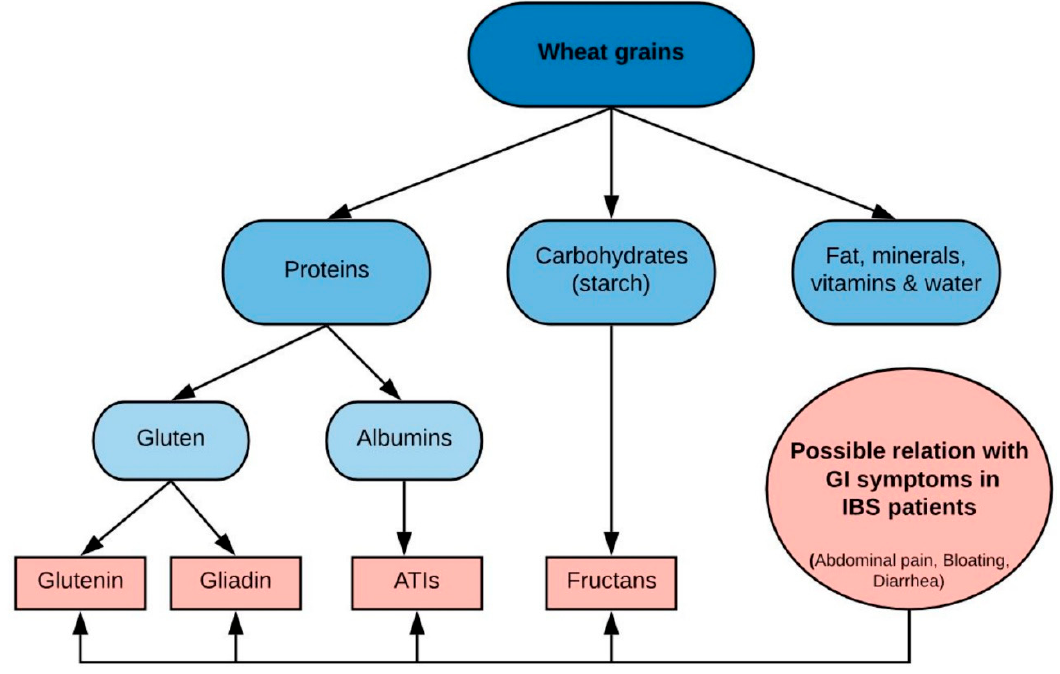
Figure 6. Schematic overview of wheat grain components and relation to gastrointestinal symptoms in IBS. Abbreviations: ATIs: amylase-trypsin inhibitors; GI: gastrointestinal; IBS: irritable bowel syndrome. Created with BioRender.